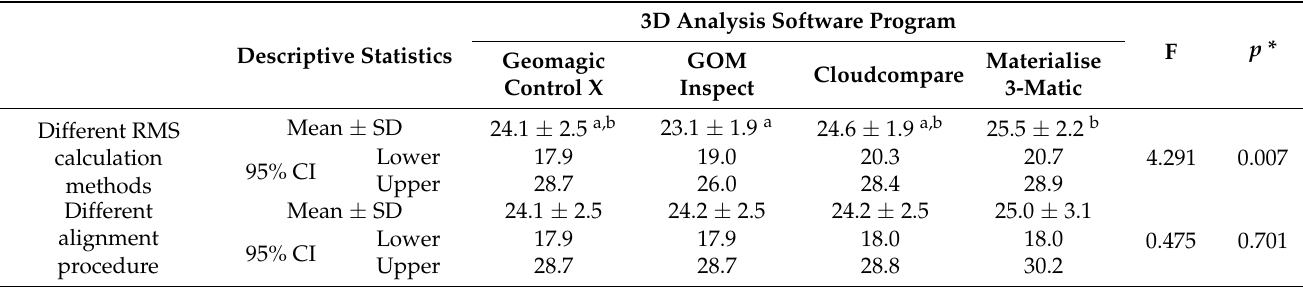
Table 3. Comparison of RMS ( µ m) of tooth preparation region evaluated by using an identical alignment procedure and RMS calculation.